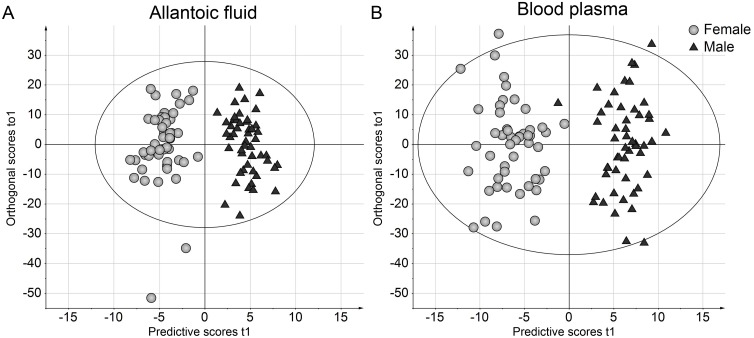
OPLS-DA score scatter plots of sex differences in the metabolic profile in (A) allantoic fluid and (B) plasma.Chicken embryos were treated by in ovo injection on E7 and were sampled on E12. Embryos from all studied treatment groups were assigned to two different classes based on their sex. The ellipse shows a Hotelling's T2 95% confidence area. Axes show score vectors (t) of predictive latent variable 1 and orthogonal latent variable 1. Model statistics are shown in Table 4.